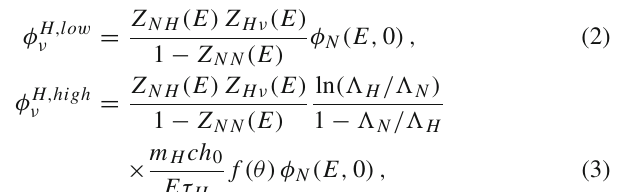
Z -moment method [39], the hybrid approach for